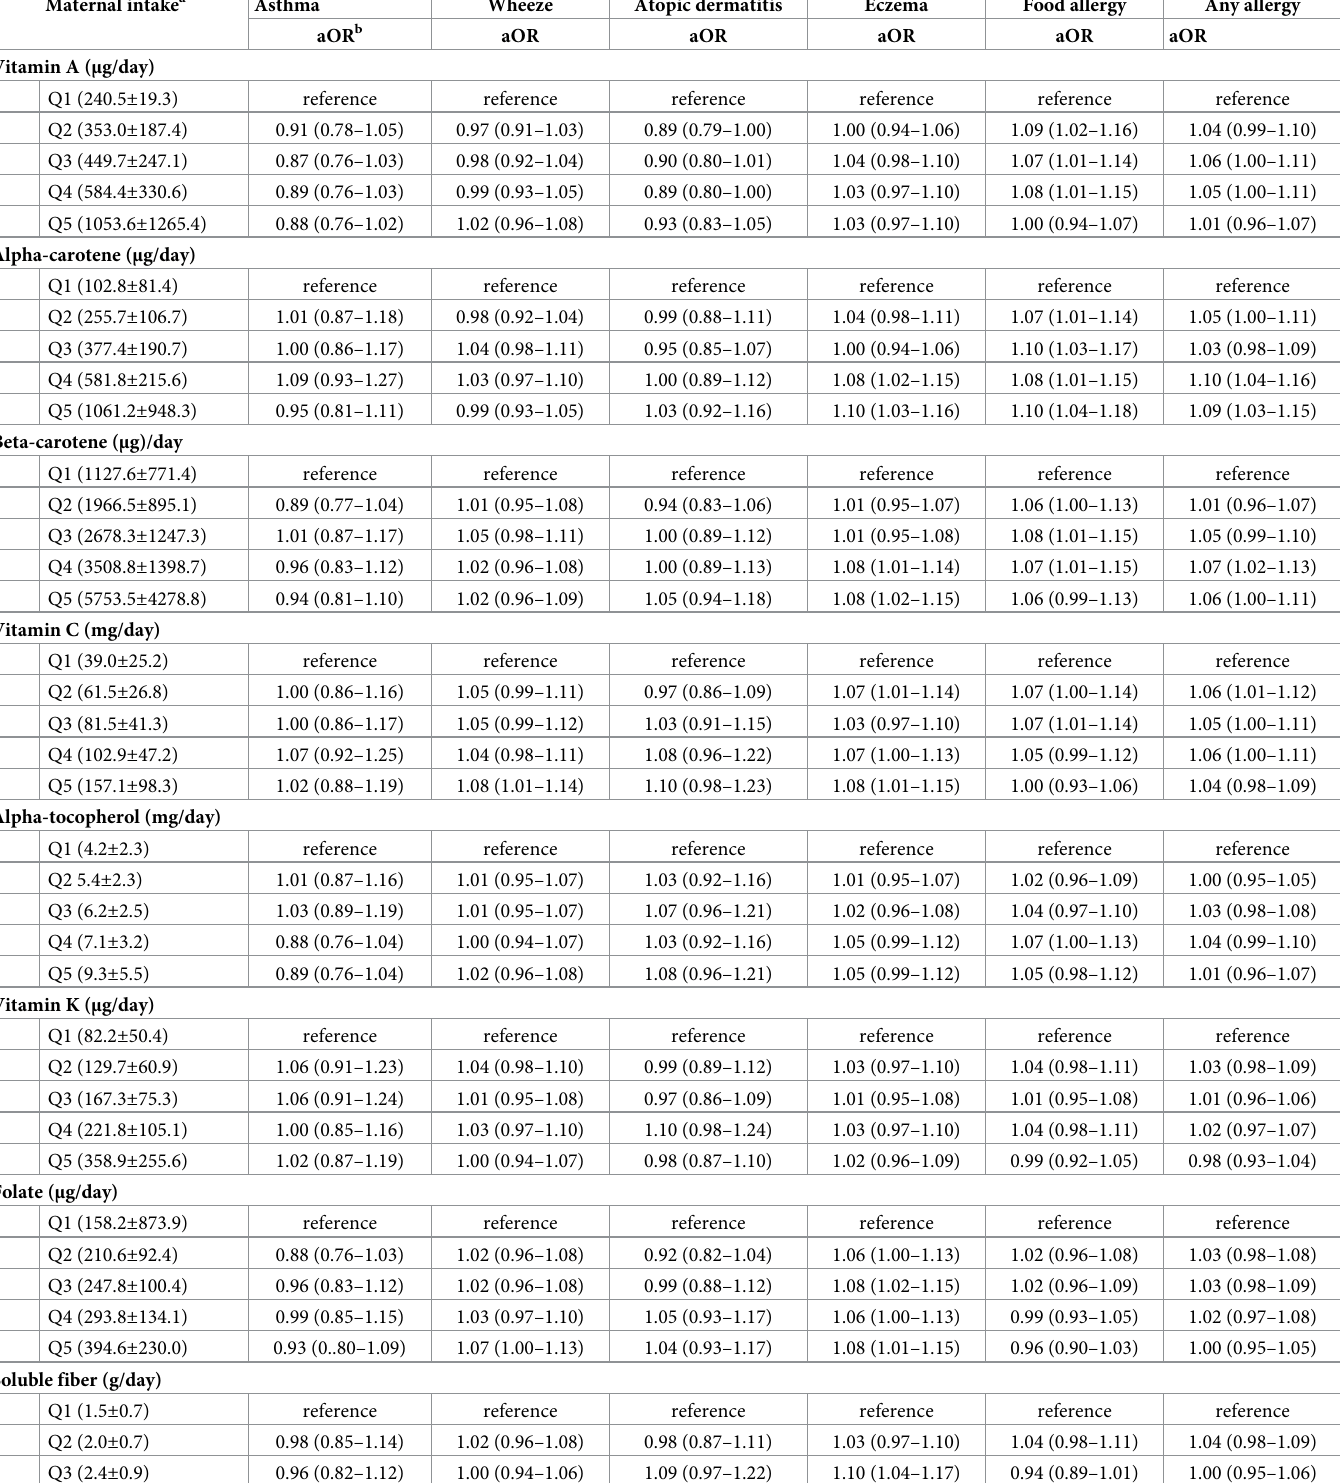
Table 3. Association between maternal nutritional intake and allergic diseases in offspring. Maternal intake